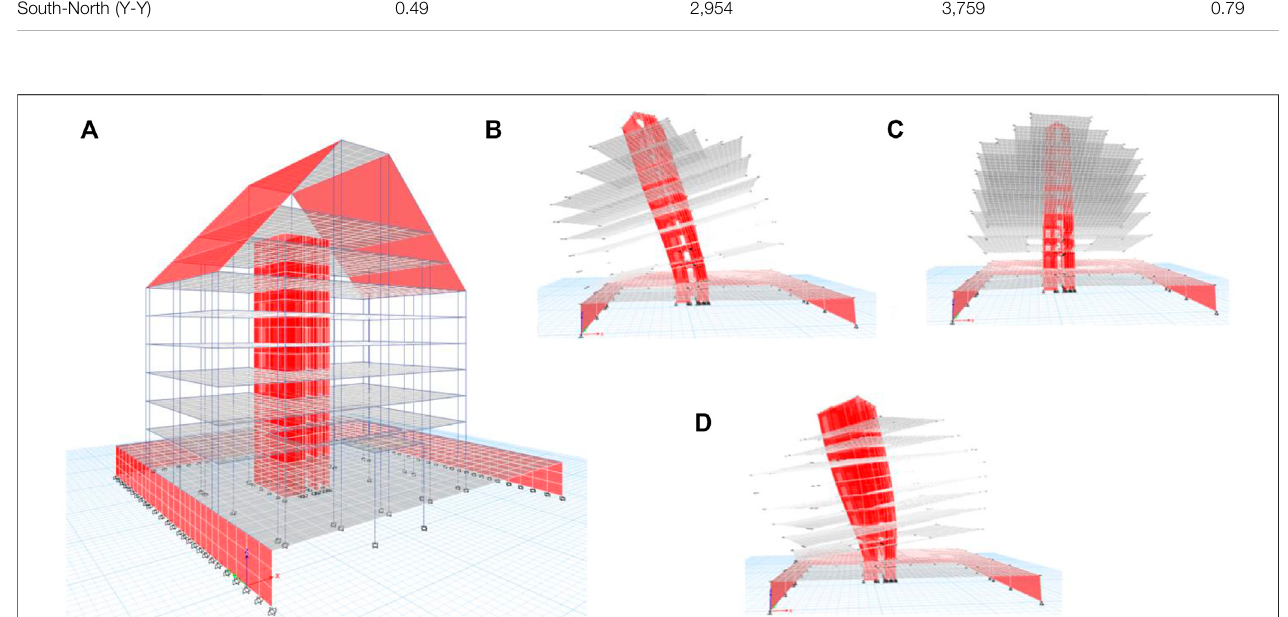
FIGURE10| ModelShapesoftheLLRS: (A) ETABSModeoftheLLRS; (B) FirstMode:TranslationinEast-West; (C) SecondMode:TranslationinSouth-North; (D) Third Mode: Torsion.